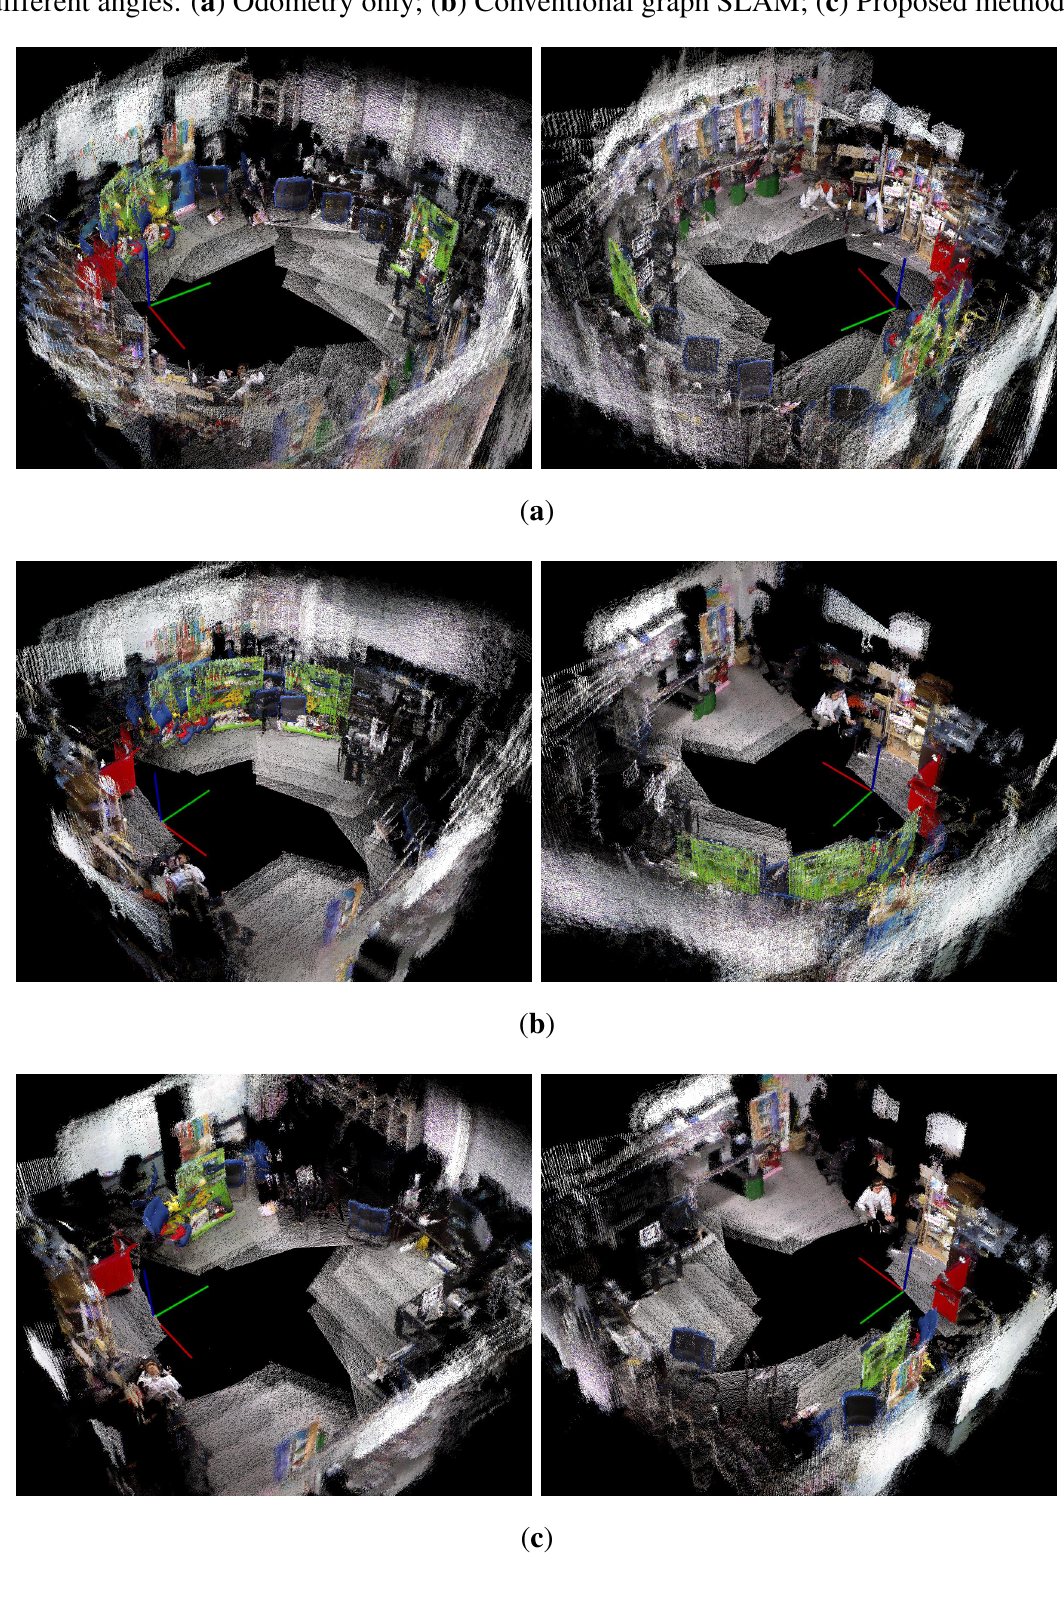
Figure 28. The 3D maps obtained from experiment 2. Left and right columns are views from different angles. ( a ) Odometry only; ( b ) Conventional graph SLAM; ( c ) Proposed